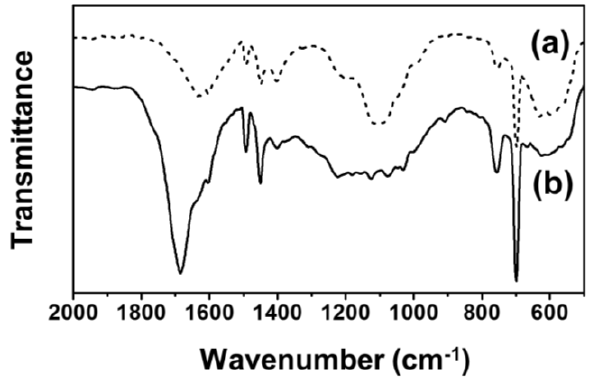
Figure 2. Fourier transform-infrared (FT-IR) spectra of ( a ) Fe ( b ) Fe O -PSt/PTh core/shell 3 4